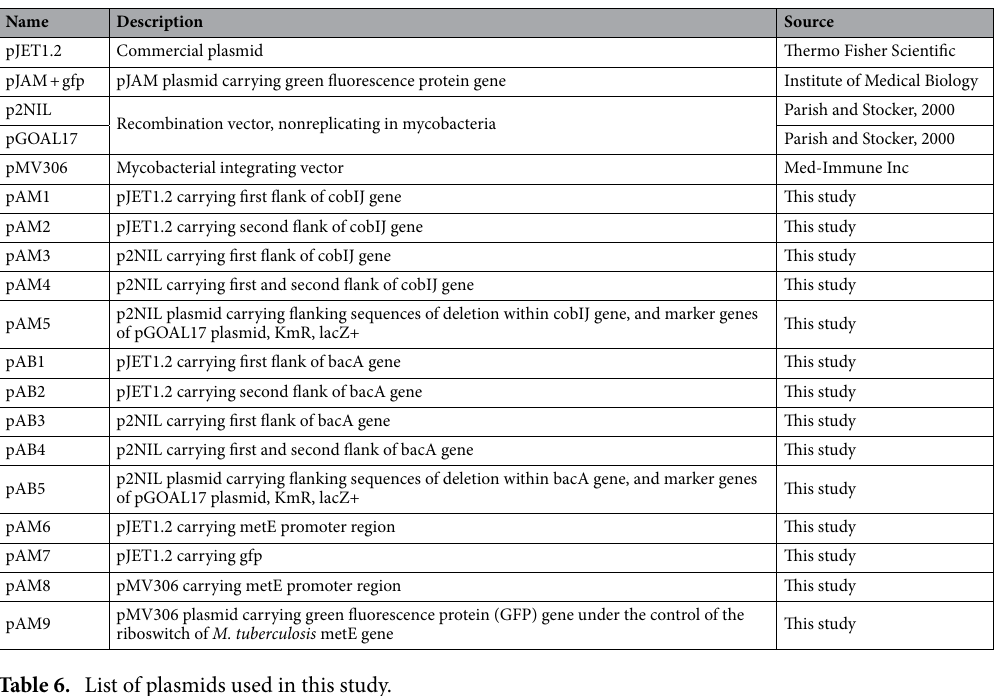
Table 6. List of plasmids used in this study.